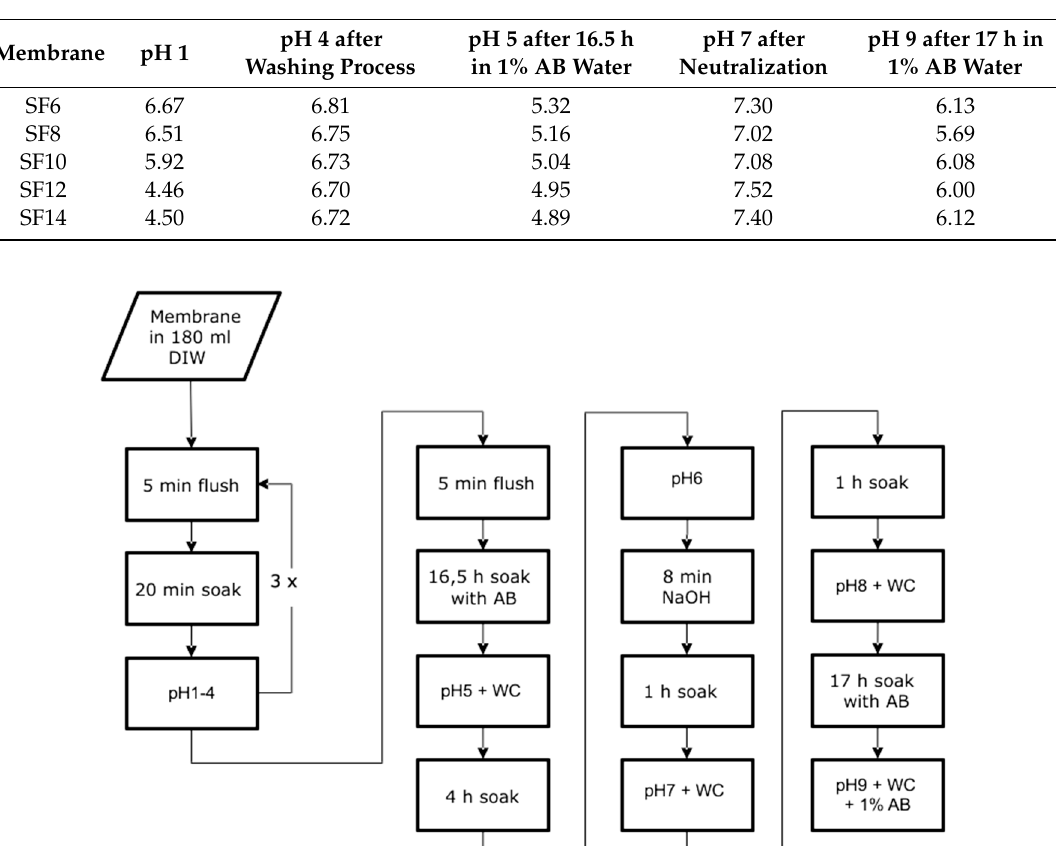
Table 1. pH values during washing and neutralization. pH 1 to pH 9, indicating the exact time of measurement, which can be tracked using the flow chart in Figure 1. AB = 1% Antibiotic (Pen Strep (Gibco Life Technologies, Carlsbad, CA, USA) with 10.00 units/mL Penicillin and 10.00 μ g/mL